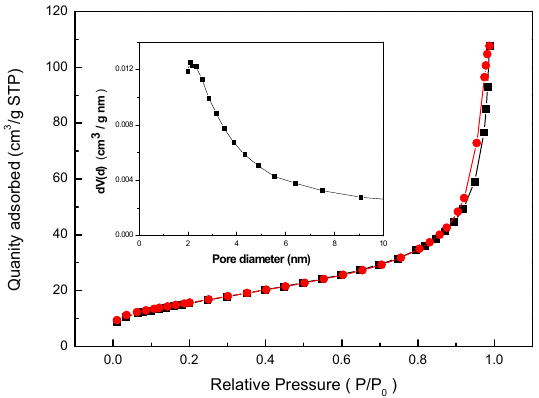
Figure 3. Nitrogen adsorption-desorption isotherm and BJH pore size distribution (inset) of BISIN.